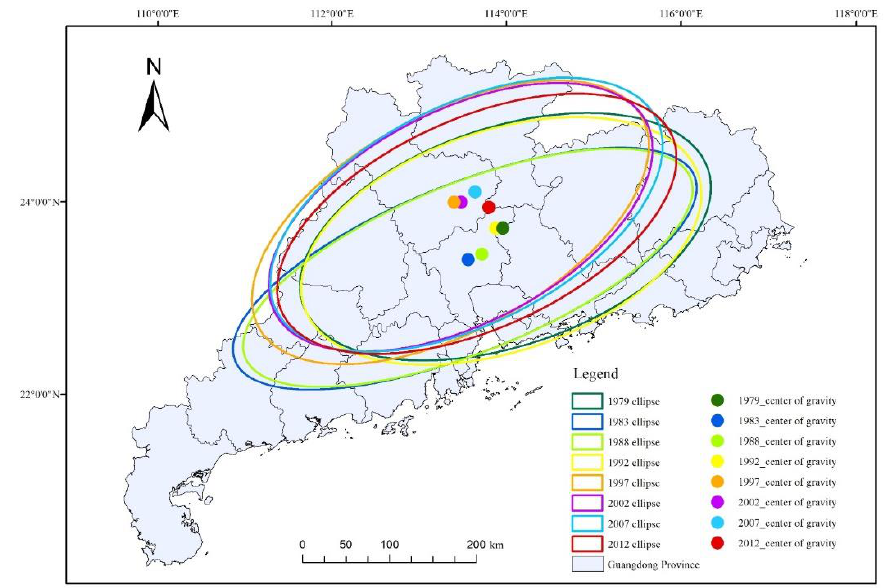
Figure 5. Spatial changes of forest carbon storage in Guangdong Province from 1979 to 2012.